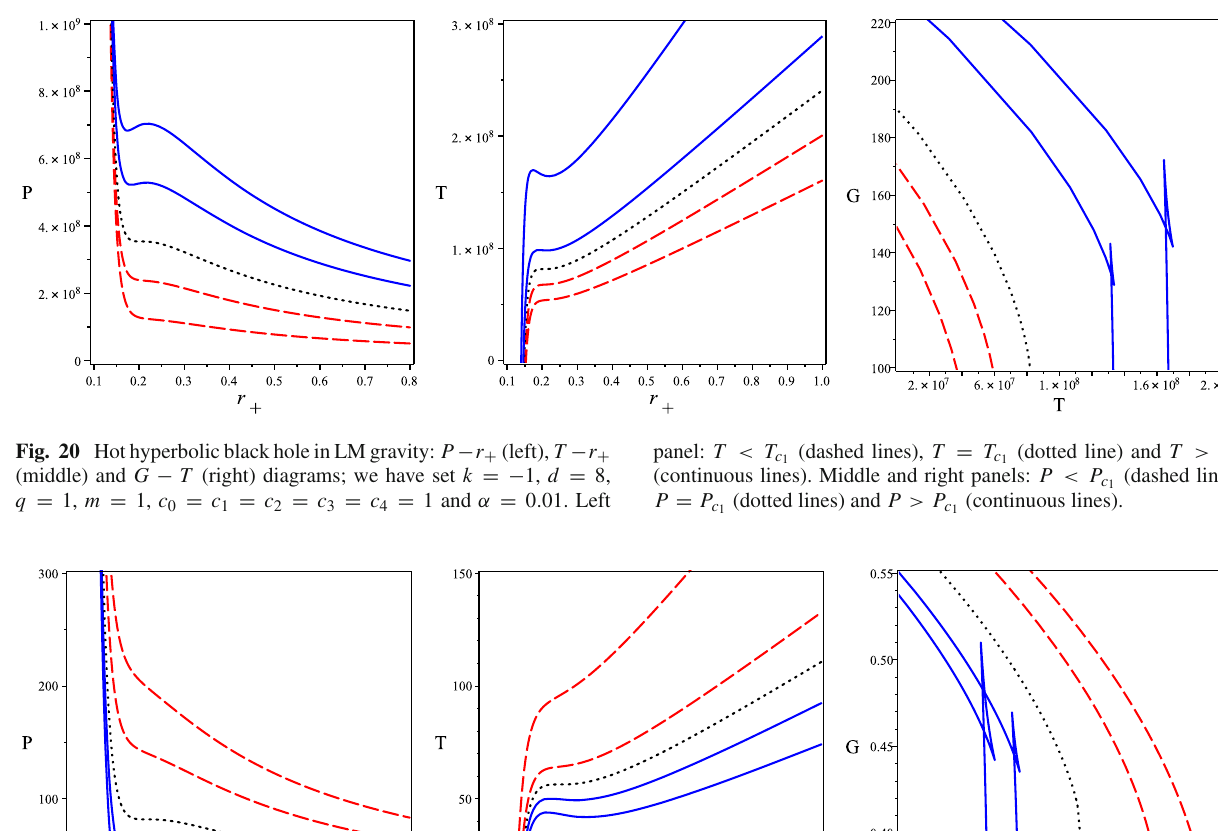
T < T c (continuous lines), T = T c (dotted line) and T > T c (dashed 2 2 2 lines). Middle and right panels: P < P c (continuous lines), P = P c 2 2 (dotted lines) and P > P c (dashed 2